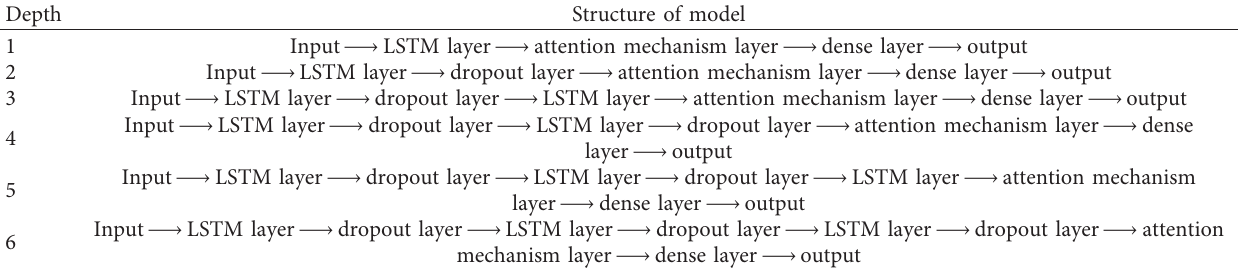
Table 2: Structures of model at different depths.